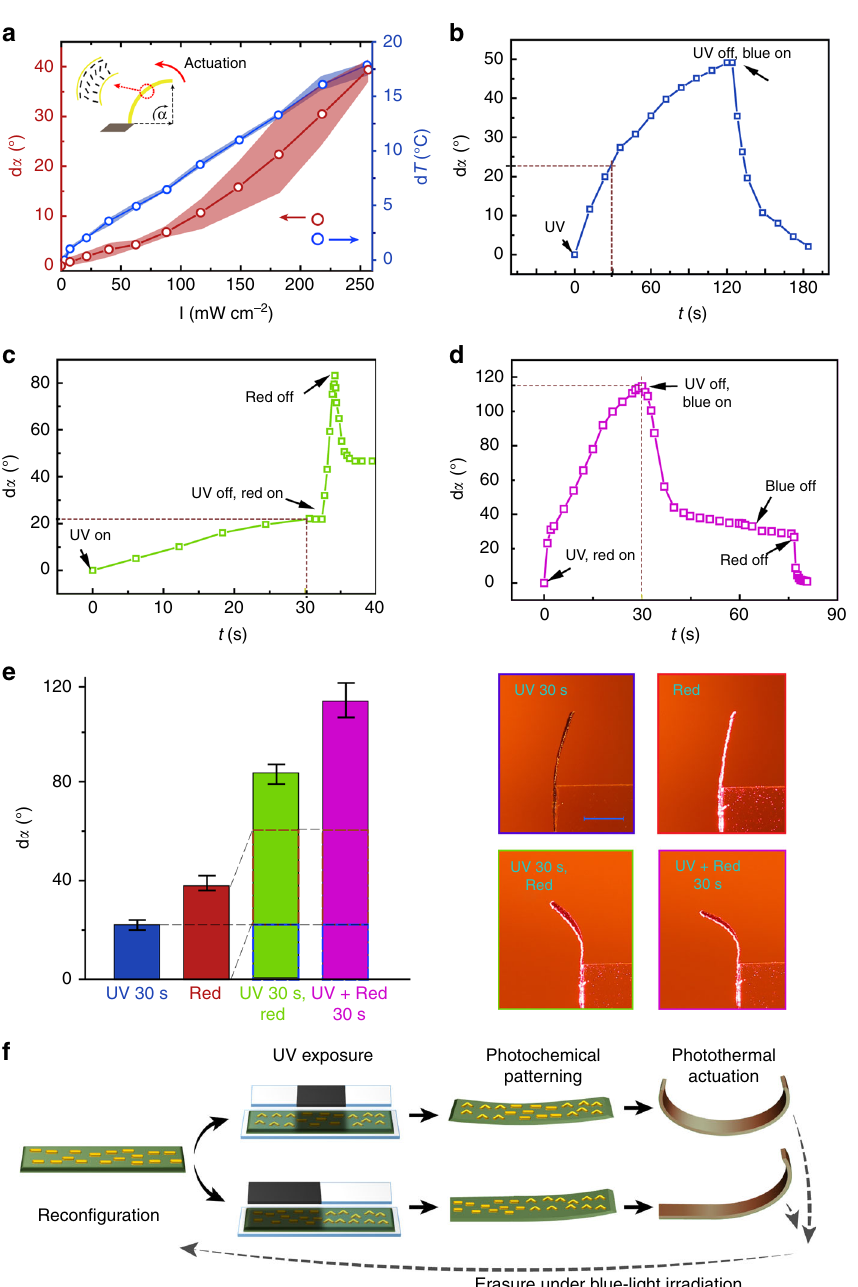
Fig. 3 Photoinduced bending upon photochemical and/or photothermal triggering. a Change of bending angle d α and maximum enhanced temperature as a function of red-light irradiation intensity. The error bars indicate standard deviation for n = 3 measurements. Inset shows the schematic drawing of the measured bending angle and actuation direction in respect to the molecular alignment. b Photochemically induced bending upon subsequent UV and blue light excitations. c Synergistic actuation using subsequent UV and red-light illumination. d Synergistic actuation under simultaneous UV and red-light illumination. e Bending angle change upon different stimuli. Error bars indicate standard deviation for n = 3 measurements. Photographs show the deformation of the same sample upon different illumination. Scale bar: 2 mm. f Schematic drawing of recon fi guration strategy by synergistically